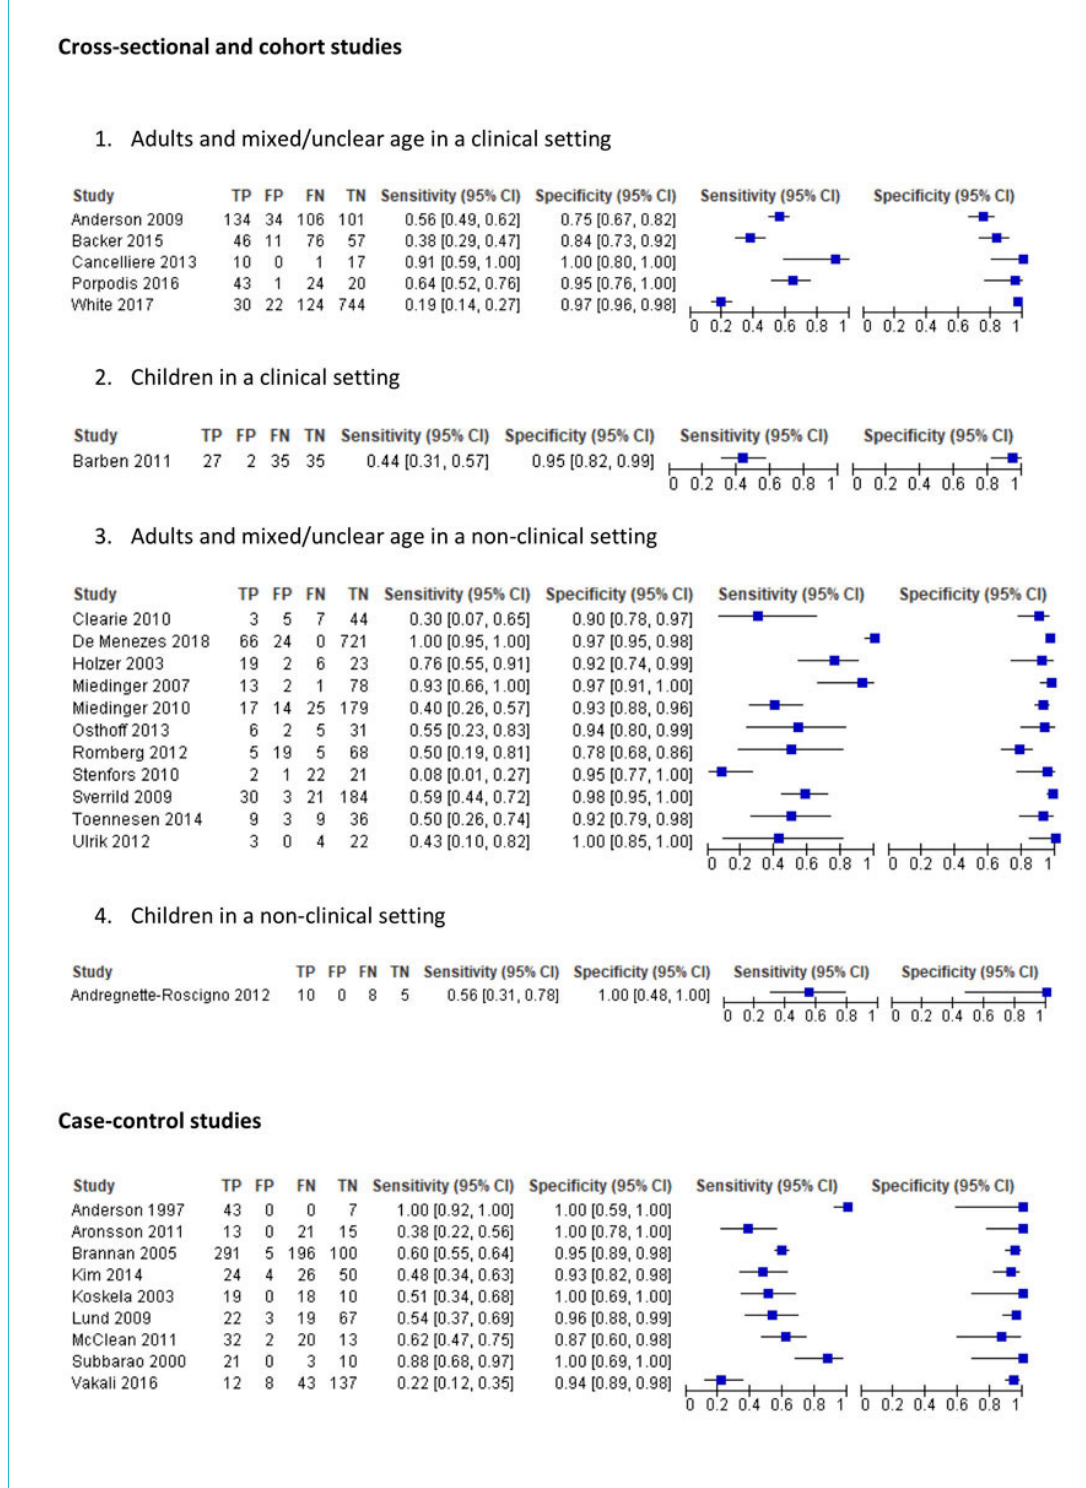
Figure 3: Forest plot of the sensitivity and specificity of the mannitol test showing several subgroups of the included cross-sectional studies (n = 18) and case-controlled studies (n = 9).TP = true positive; FP = false positive; FN = false negative; TN = true negative; CI = confidence